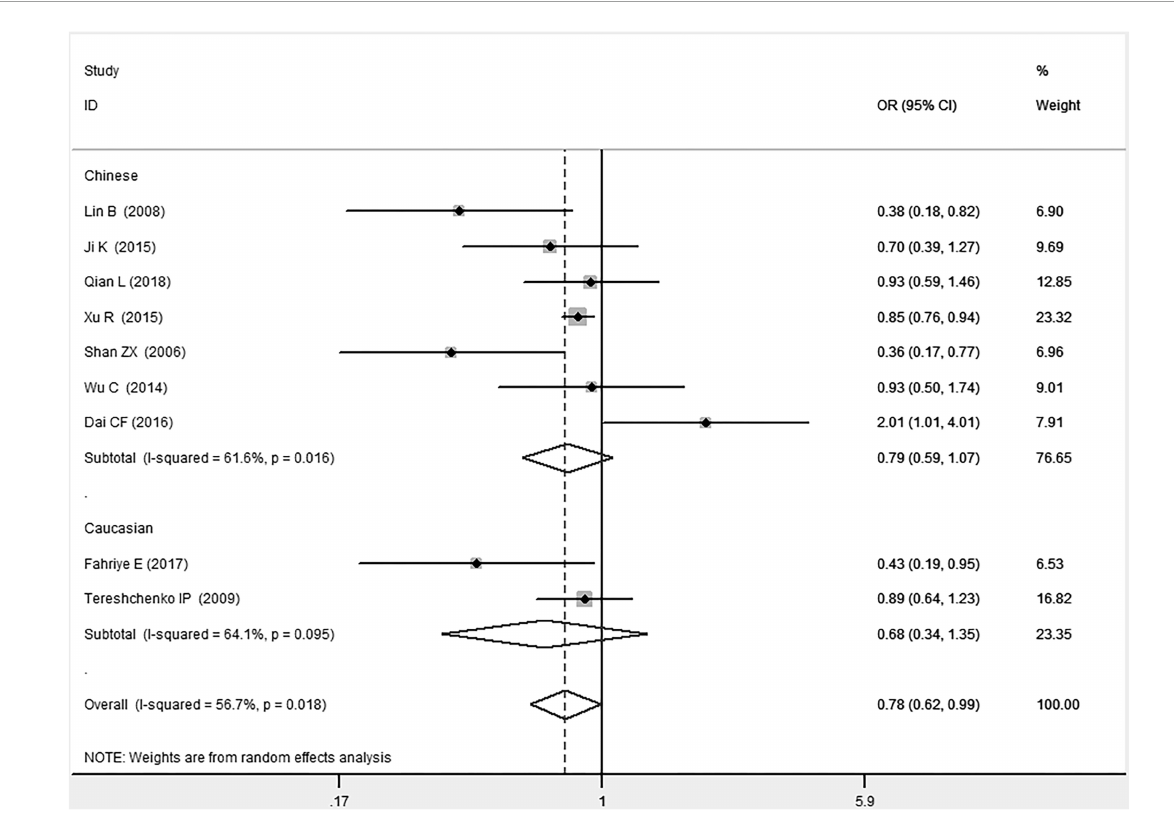
FIGURE3 Forest plot of CAD associated with MIF gene rs755622 G/C polymorphism under a dominant genetic model (i.e., GG vs. GC + CC of MIF gene rs755622 G/C polymorphism).